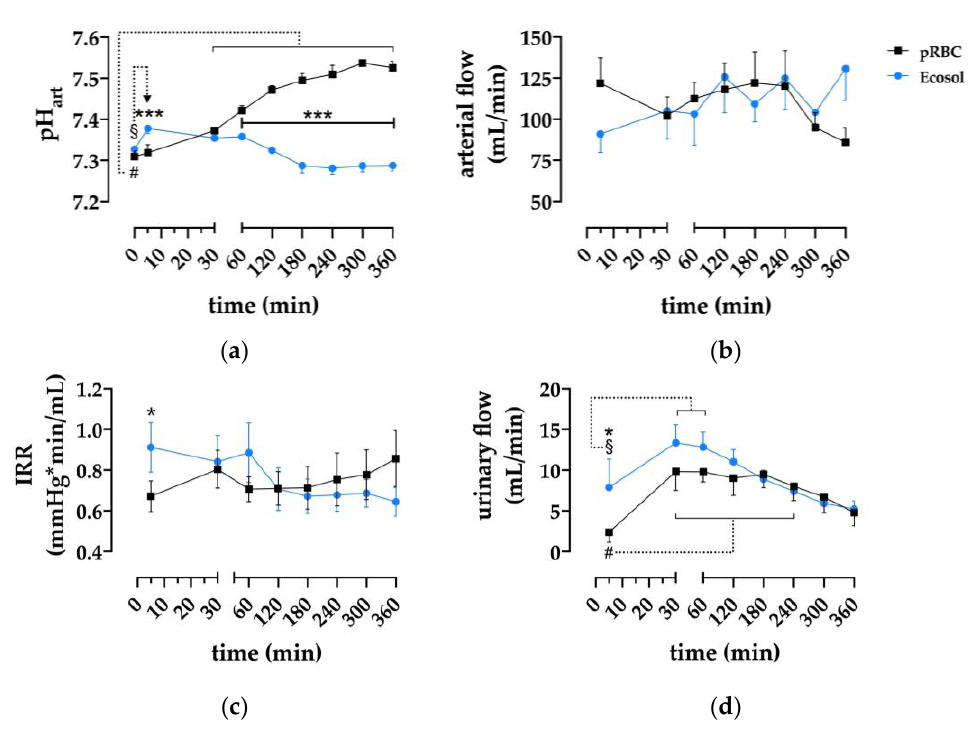
Figure 2. Assessment of renal perfusion parameters. ( a ) Effect of time and perfusion medium on arterial pH; ( b ) arterial flow of kidneys during perfusion; ( c ) dtatistical analysis of intrarenal resistance during machine perfusion; and ( d ) urinary flow during 6 h NMP; * p < 0.05, *** p < 0.001 (pRBC vs. Ecosol); # p < 0.05 (pRBC time point vs. pRBC baseline); § p < 0.05 (Ecosol time point vs. Ecosol baseline).